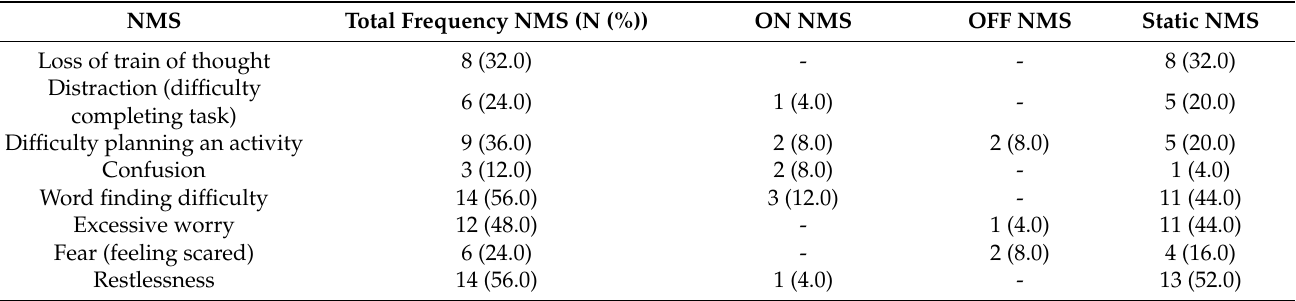
Table 2. Frequencies of total, fluctuating (ON and OFF), and static non-motor